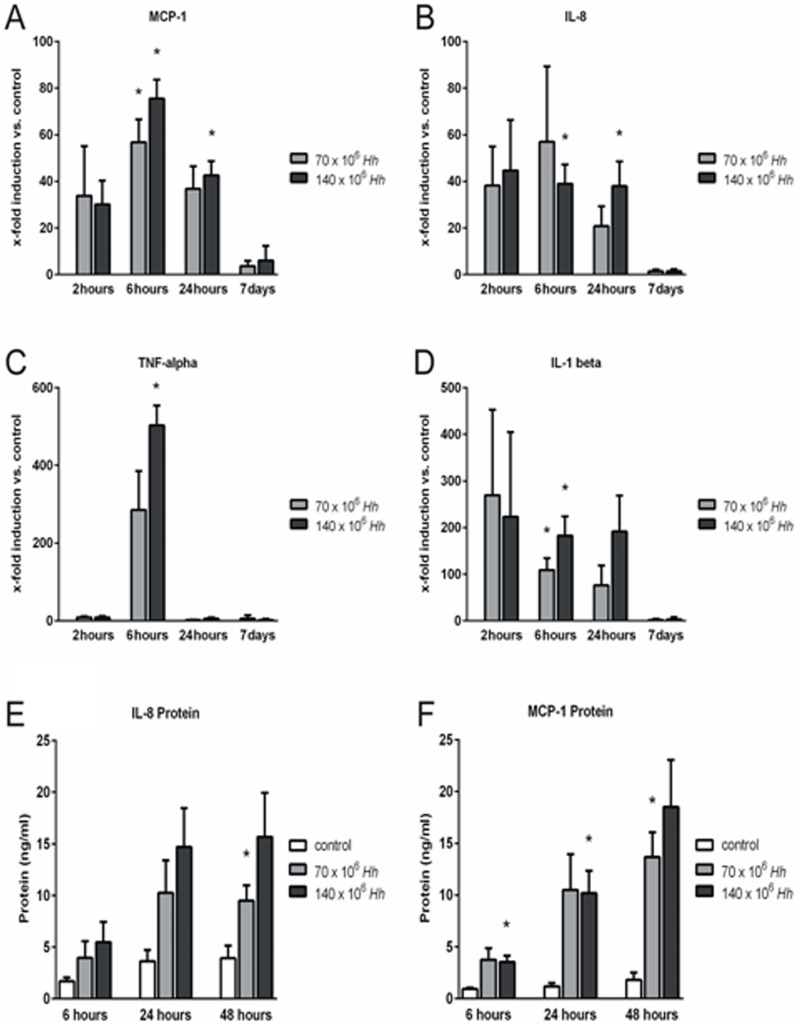
Primary human hepatocytes (PHH) express acute phase cytokines in response to co-cultivation with H. hepaticus.PHH were co-cultured with H. hepaticus ATCC 51449 at a MOI of 50 (70×106 Hh) or 100 (140×106 Hh) bacteria per hepatocyte (n = 3). Real-time RT PCR of hepatocytes revealed increased mRNA expression of the acute phase cytokines Monocyte chemotactic protein 1 (MCP-1) (A), Interleukin 8 (IL-8) (B), Tumor necrosis factor alpha (TNF-alpha) (C) and Interleukin 1 beta (IL-1 beta) (D). Cytokine mRNA is expressed as the fold induction compared to untreated control culture from the same hepatocyte donor for each time point (A-D). Up-regulation of acute phase cytokine mRNA in hepatocytes resulted in an increased IL-8 (E) and MCP-1 (F) concentration in the supernatant of infected PHH as measured by ELISA. Data shown as mean±SEM, n = 3. * = p<0.05 versus control.